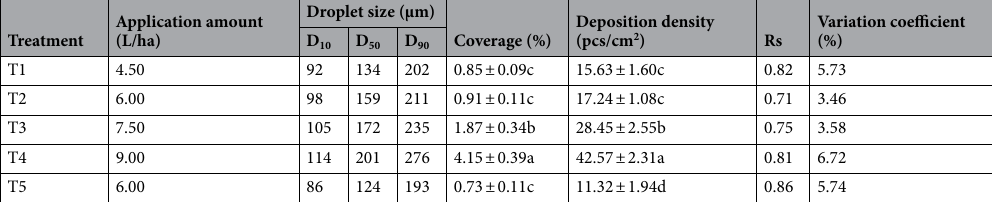
Table 5. Droplet size, coverage, deposition density, spectral width and variation coefficient for each treatment. Different letters (a, b, c, and d) indicate significant differences between means. Means followed by the same letter are not significant at the 5% significance level by the LSD test (LSD = 0.05). A number that follows the ± sign is a standard deviation